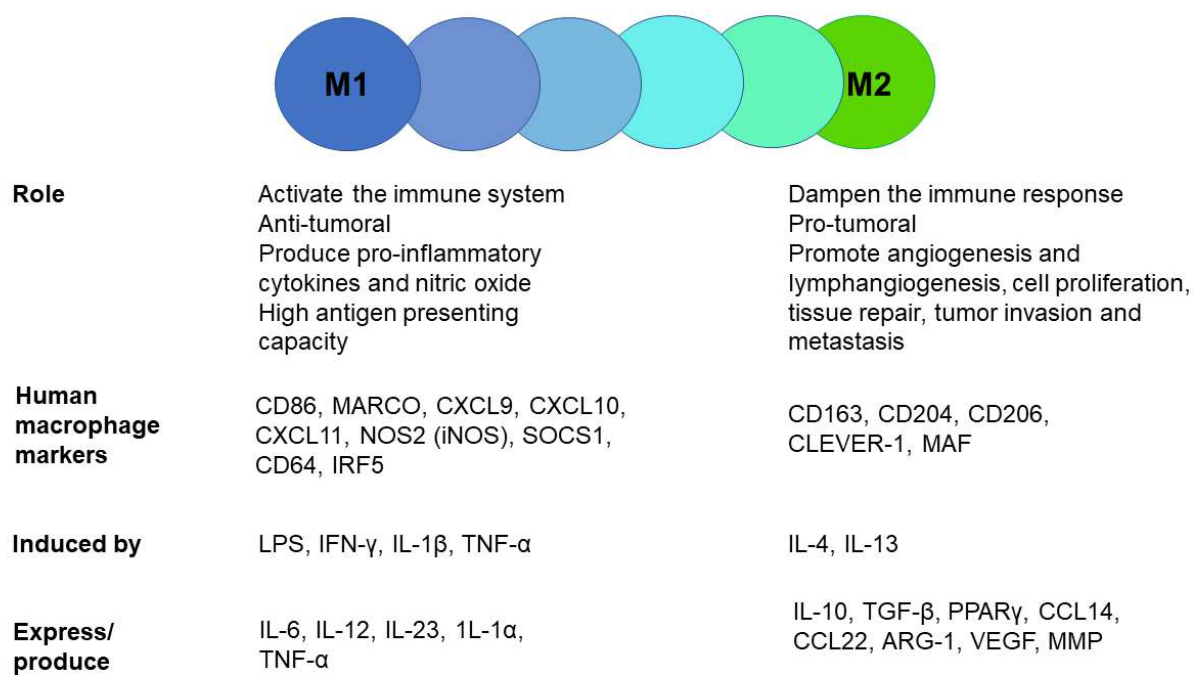
Figure 1. The role and characteristics of M1 and M2 macrophages representing the two extremes of the macrophage polarization spectrum.